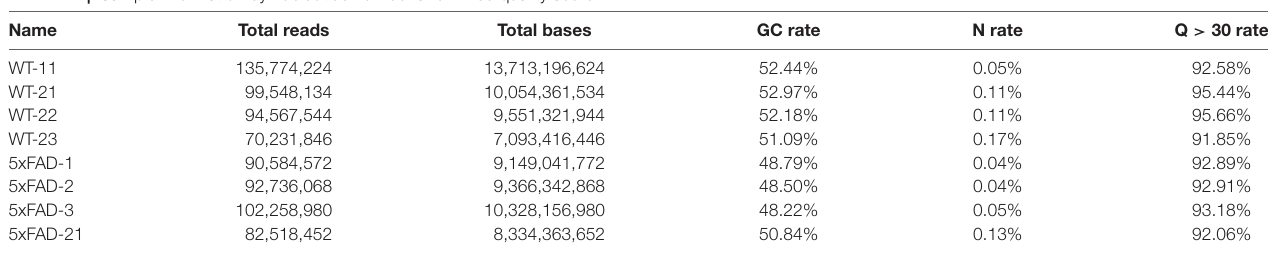
TABLE 1 | Sample information by nucleotide number and Phred quality